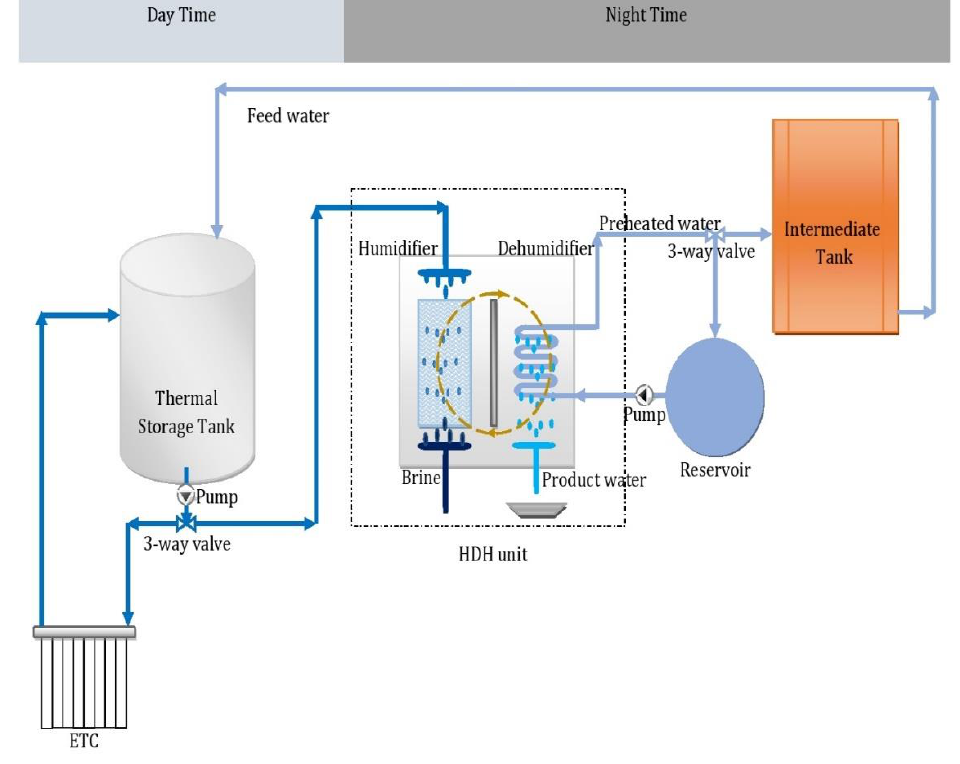
Figure 1. Overall schematic of the